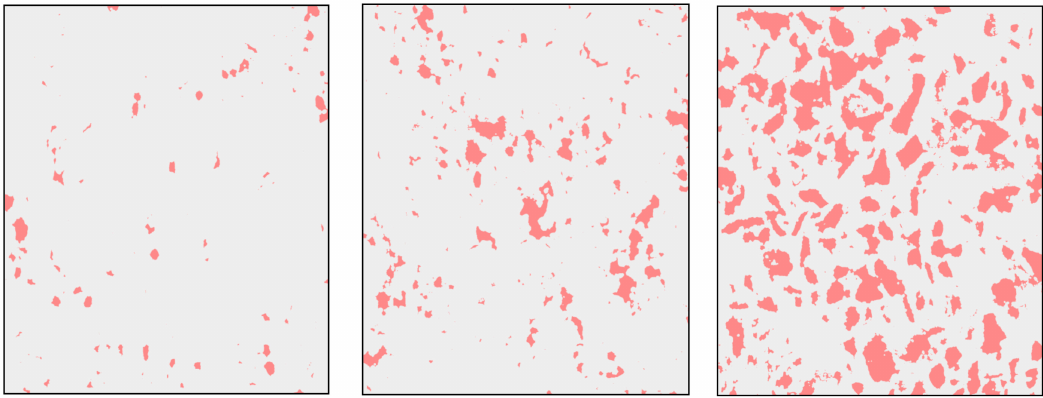
Figure 14. Projected areas for three aggregate loss levels (from left to right: minimal with a coefficient of friction of 0.79; moderate 0.56; severe 0.35).